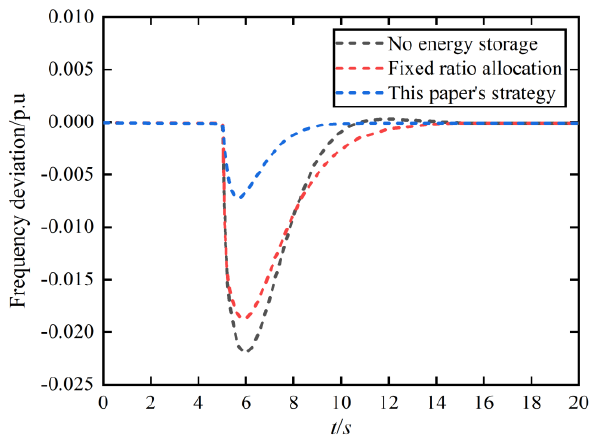
Figure 9. Frequency deviation.